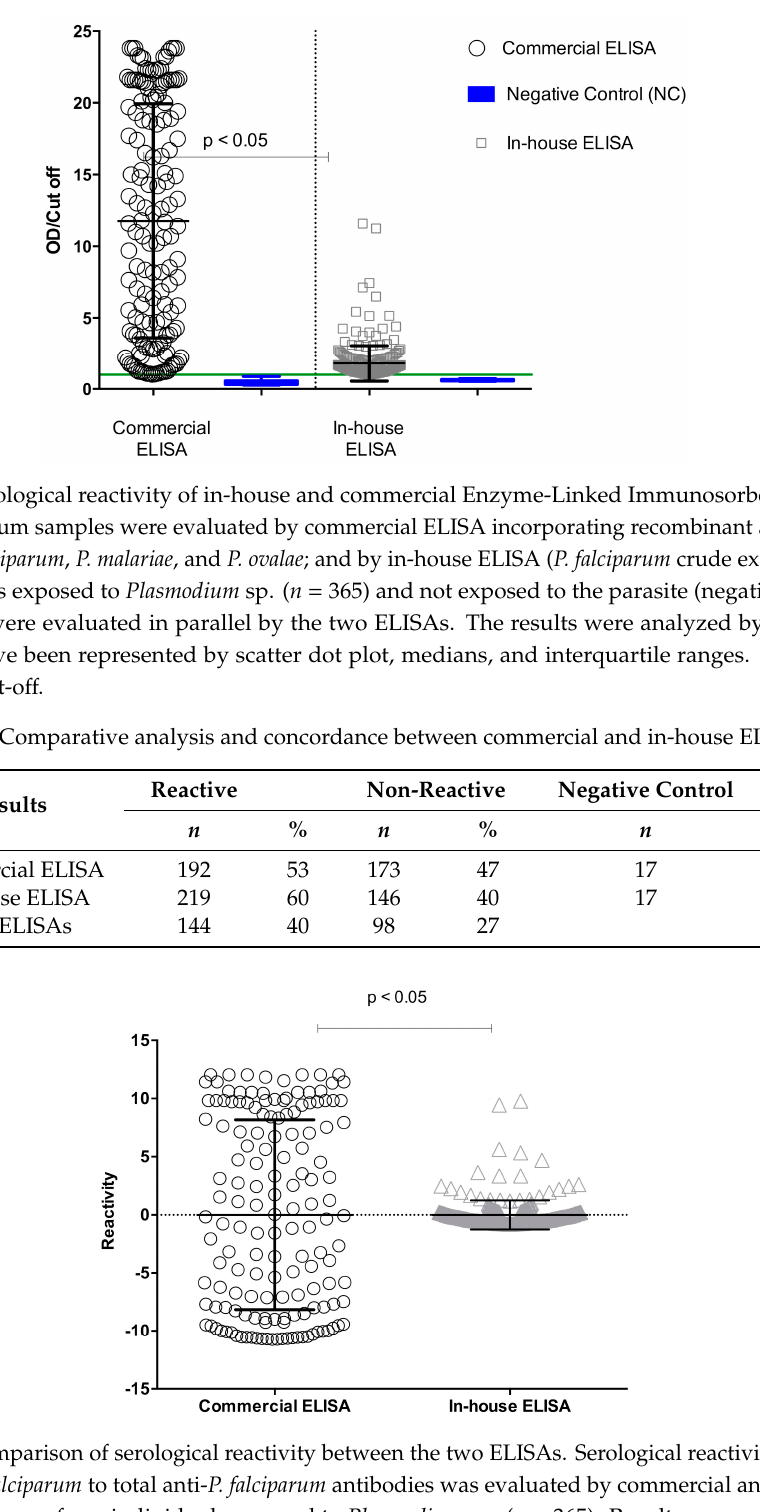
Figure 2. Comparison of serological reactivity between the two ELISAs. Serological reactivity of crude extract of P. falciparum to total anti- P. falciparum antibodies was evaluated by commercial and in-house ELISAs using sera from individuals exposed to Plasmodium sp. ( n = 365). Results were